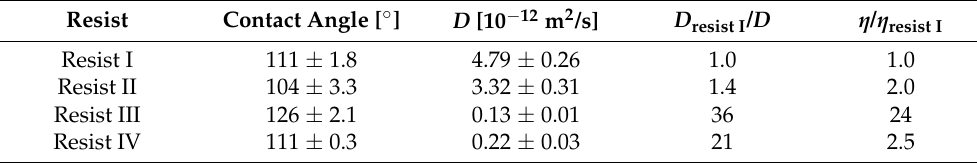
Table 2. Contact angles, diffusion coefficients of DMPA ( D ) estimated by MD simulations, the inverse ratio of D to resist I, and the ratio of the experimentally measured viscosity ( η ) to resist I. Resist Contact Angle [ ◦ ] D [10 − 12 m 2 /s] D resist I / D η / η resist I Resist I 111 ± 1.8 4.79 ± 0.26 1.0 1.0 Resist II 104 ± 3.3 3.32 ± 0.31 1.4 2.0 Resist III 126 ± 2.1 0.13 ± 0.01 Resist IV 111 ± 0.3 0.22 ± 0.03